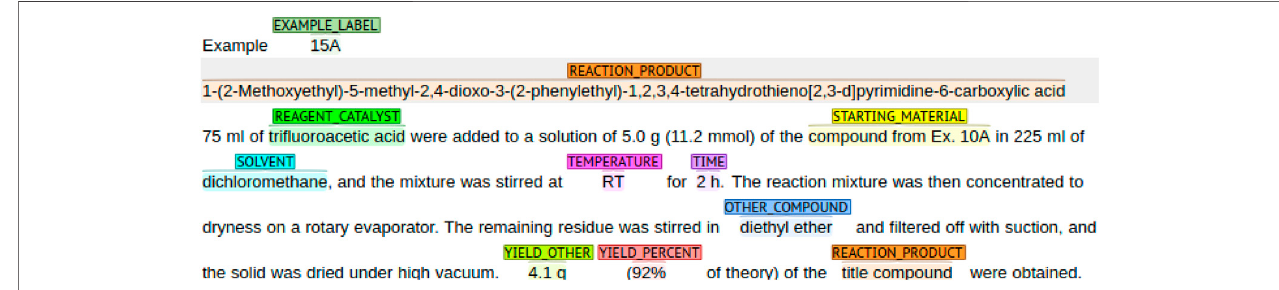
FIGURE 1 | An example of a patent passage of the ChEMU dataset with entity annotations. The annotations are color-coded, representing the different entities in the dataset.